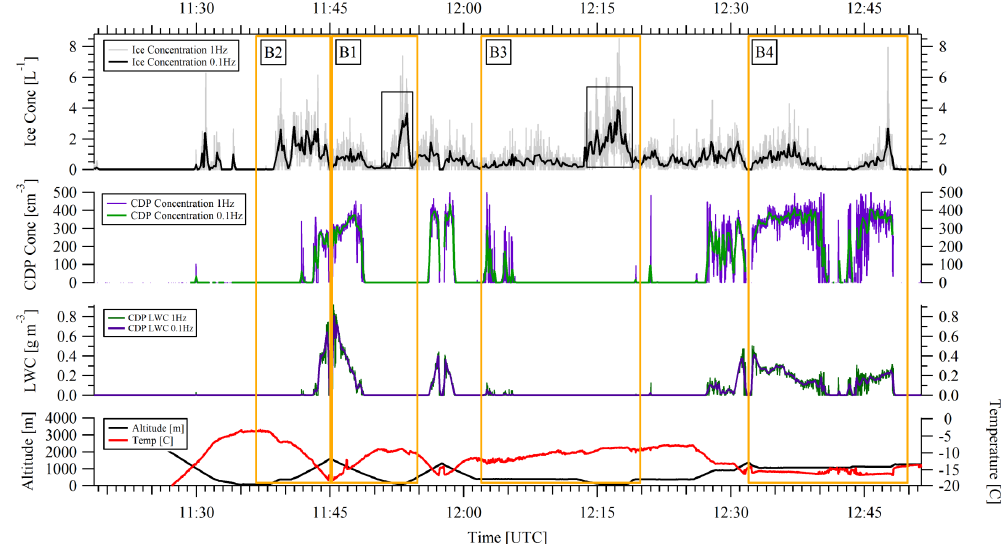
Figure 4. Microphysics time series data for spring case 2. Data includes temperature ( ◦ C) and altitude (m) (lower panel) 1 and 10s data sets for CDP liquid water content (gm − 3 ) and CDP concentration (cm − 3 ) (middle panels), and ice water content (gm − 3 ) and ice number concentrations (L − 1 ) (top panel). Profiles B2, B3 and B4 are described in the